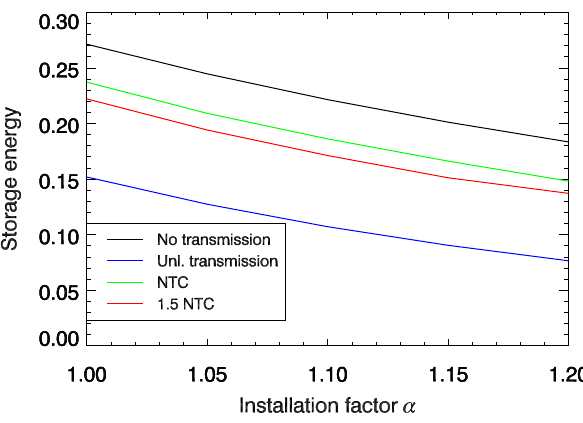
Figure 5. Storage energy needs in Europe in dependency of the installation factor α for different transmission scenarios in units of the overall